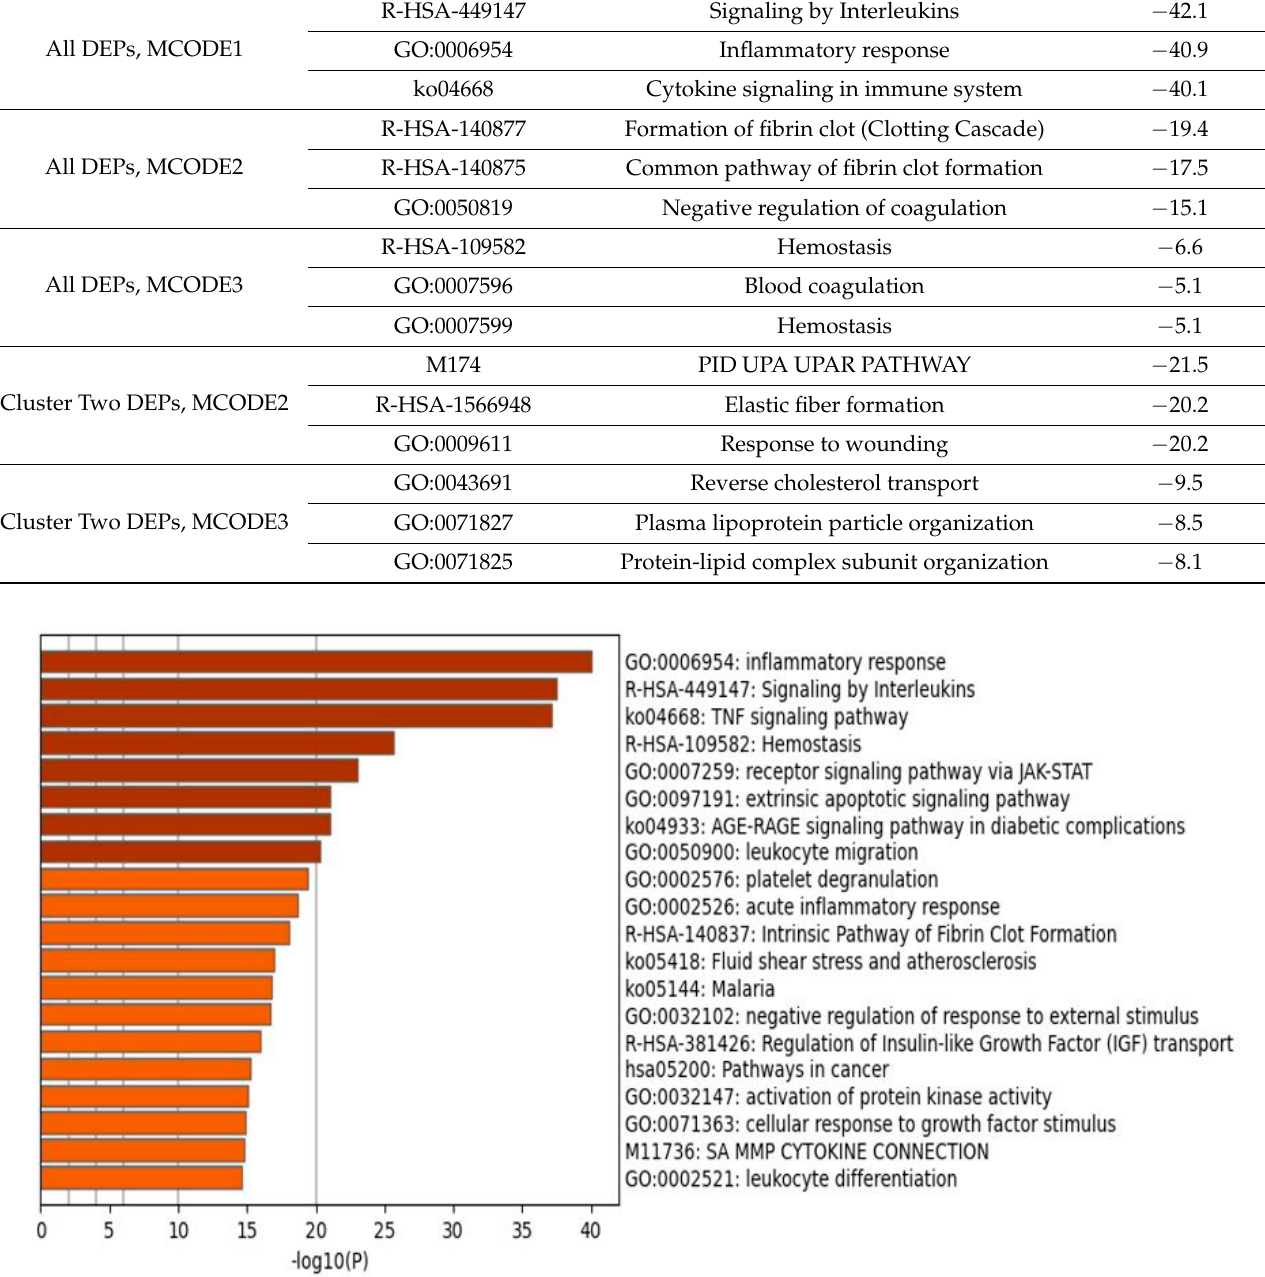
Table 1. Results of Molecular Complex Detection (MCODE) analysis performed on the differently expressed proteins (DEPs) of death due to ischemic stroke.